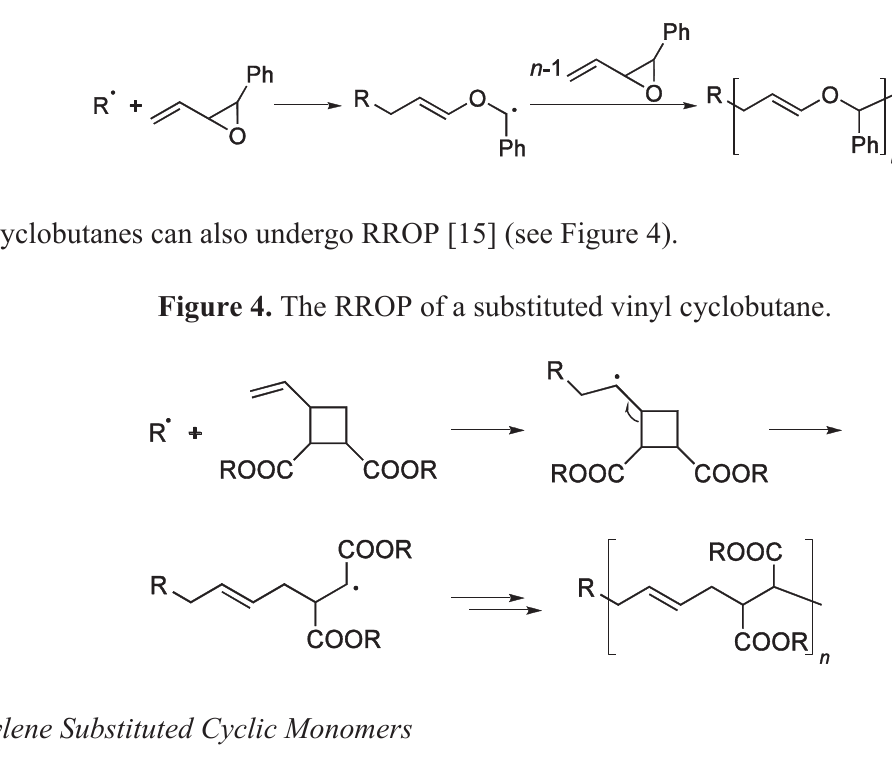
Figure 3. The RROP of phenyl (Ph) vinyl oxirane.